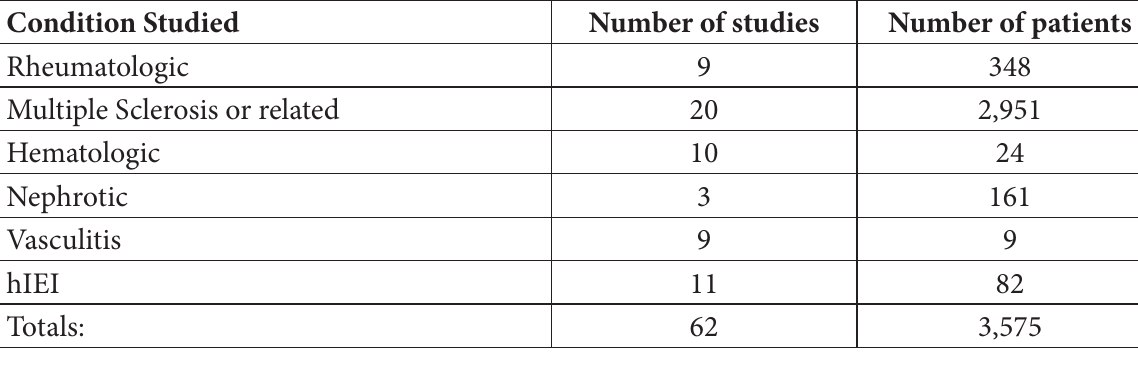
Table 1: Summary of papers included within Scoping Review Condition